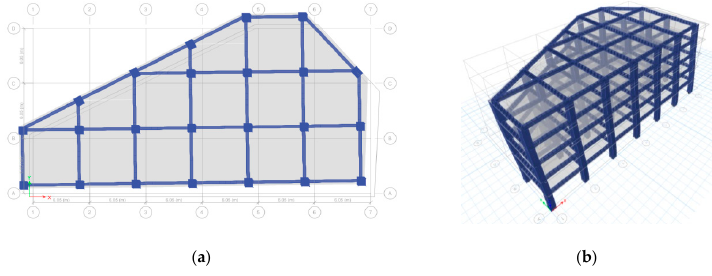
Figure 7. The 1st mode shape for T 1 = 0.480 s: ( a ) plane view, and ( b ) 3D view.